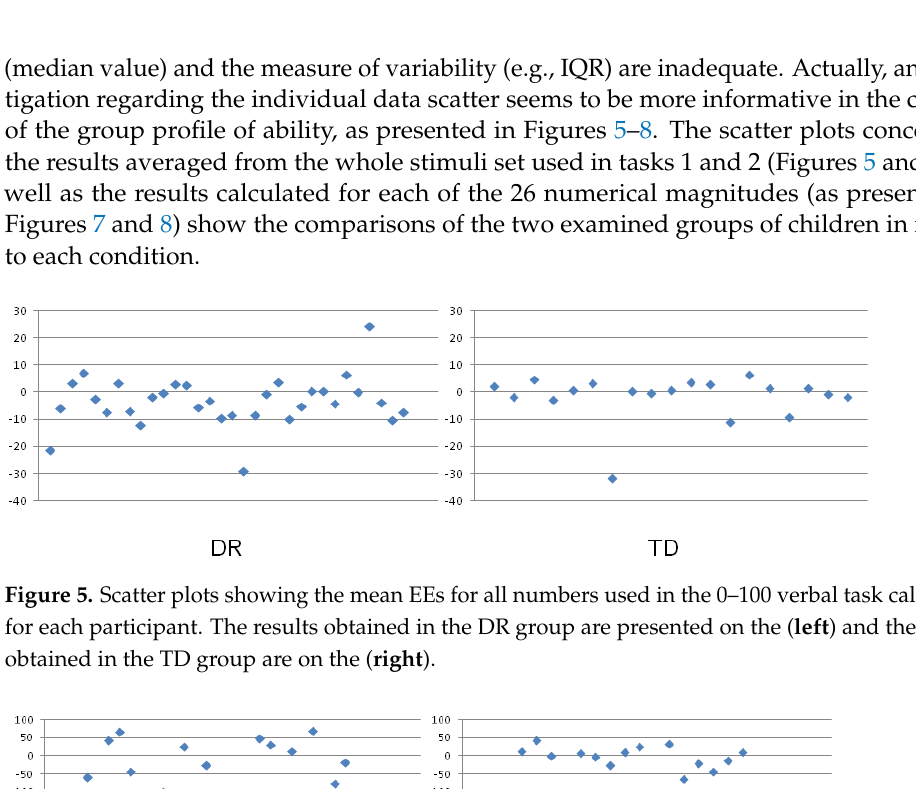
Figure 8. Scatter plots showing the mean EEs calculated for each of the 26 numbers used in the 0 – 1000 verbal task and for each participant. In each plot presenting the results obtained for a par- ticular number magnitude, the dispersion revealed in the DR group is presented in blue, and that in the TD group is presented in red . In most of these plots, there are clear differences between the groups, which are visible in the individual data dispersion around the expected number value. 4. Discussion We investigated the effect of dyscalculia risk on precision in the spatial localization of numbers on bounded empty number lines ranging from 0 to 100 and from 0 to 1000. The index of this precision level was the estimation error measured in two types of NLE tasks, in which the participants were asked (1) to verbally determine the number mag- nitude indicated on a line with an arrow and (2) to point to the place on a line related to